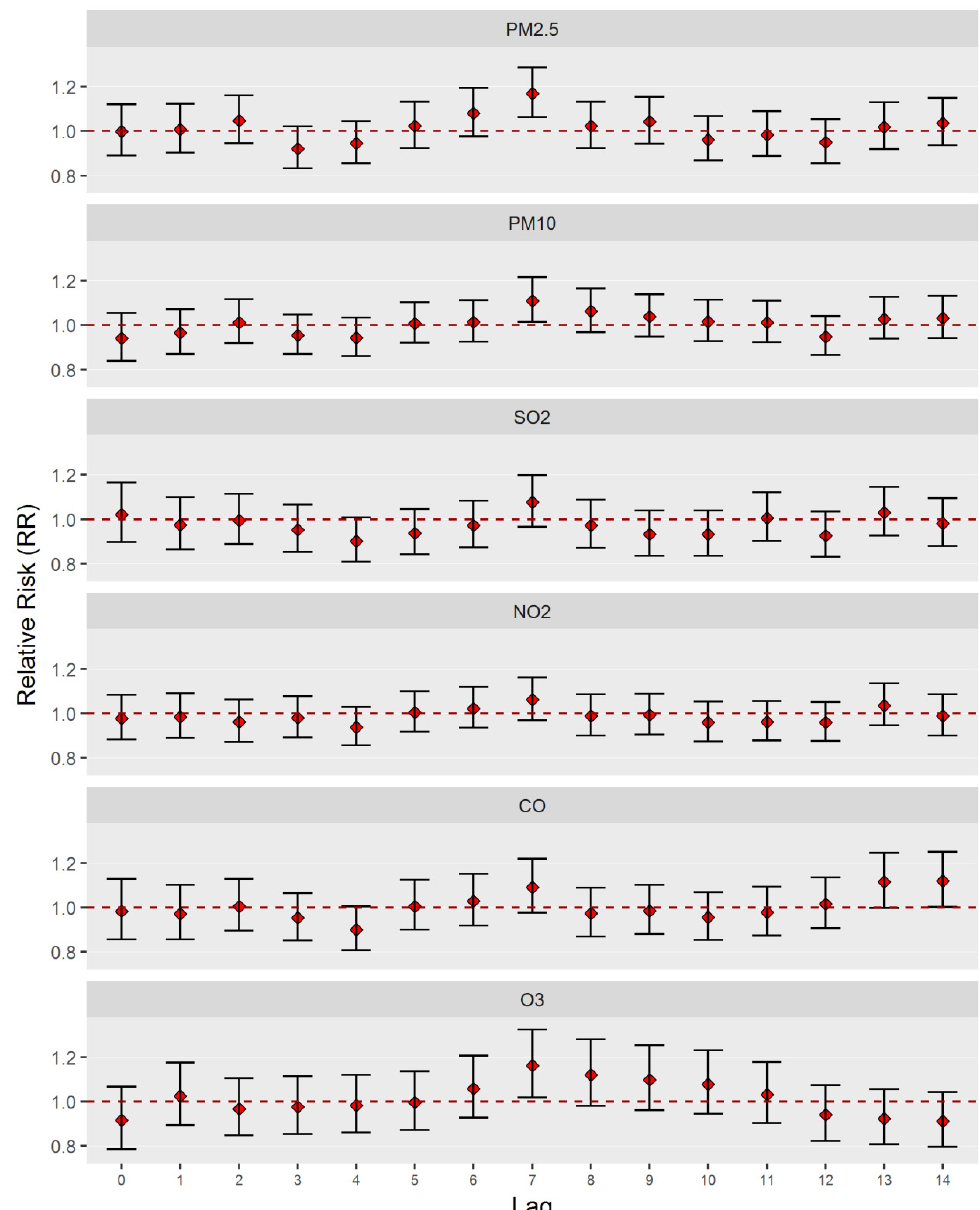
Figure 2. Relative risks (and 95% CIs) of TB incidence associated with an increase of 10 μ g/m 3 in